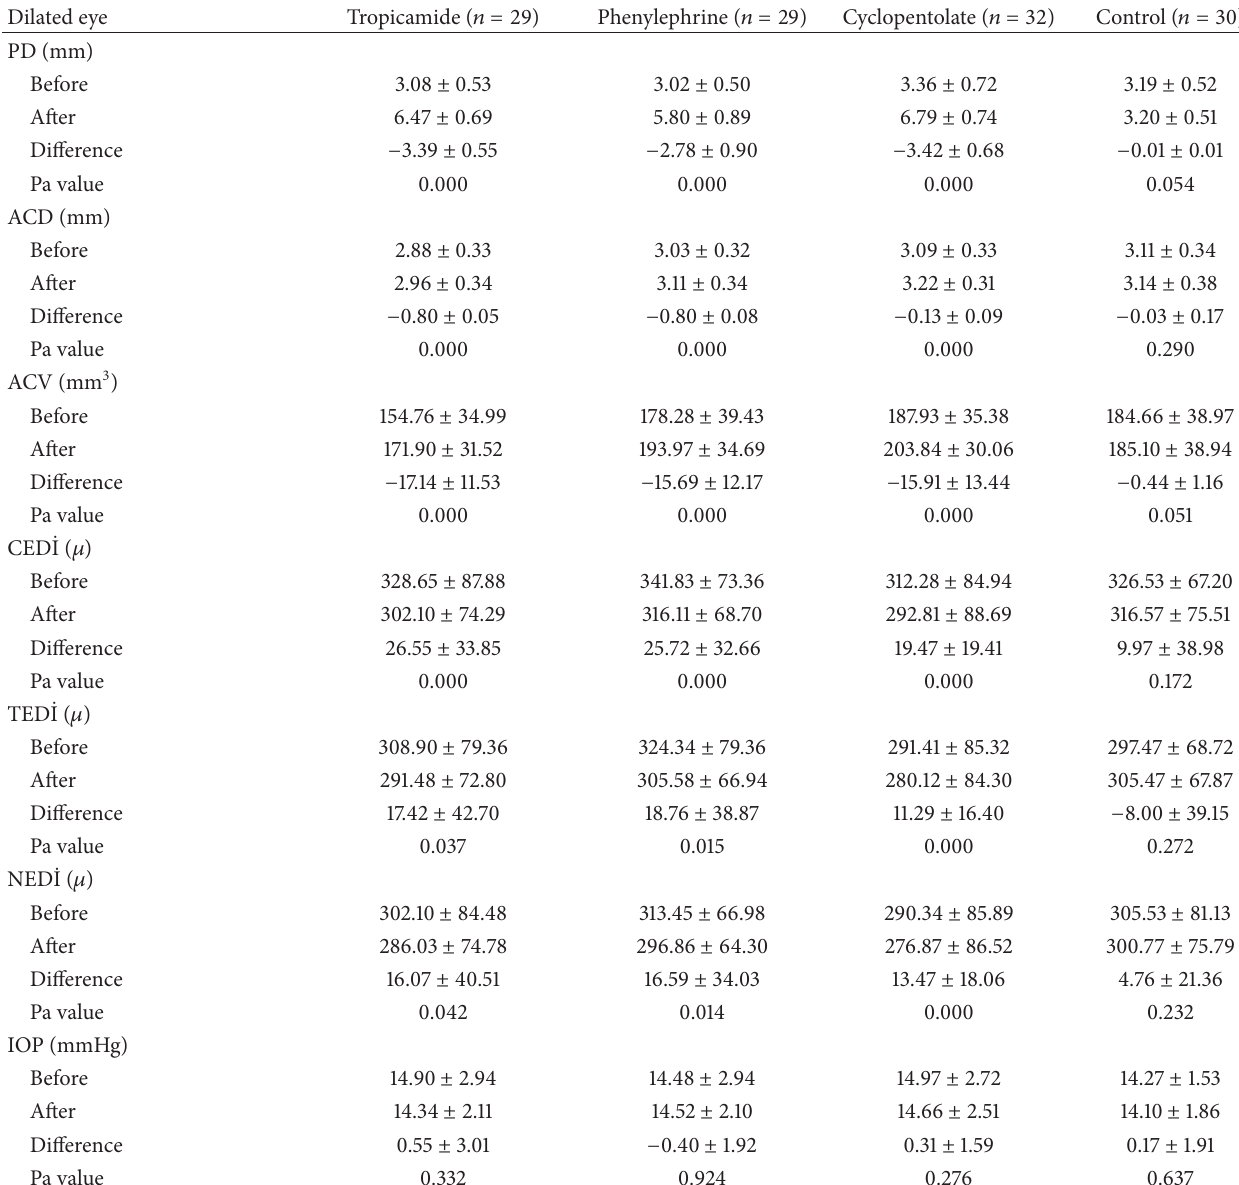
Table 2: Changes of anterior chamber parameters, choroidal thickness, and intraocular pressure before and after drug administration. Dilated